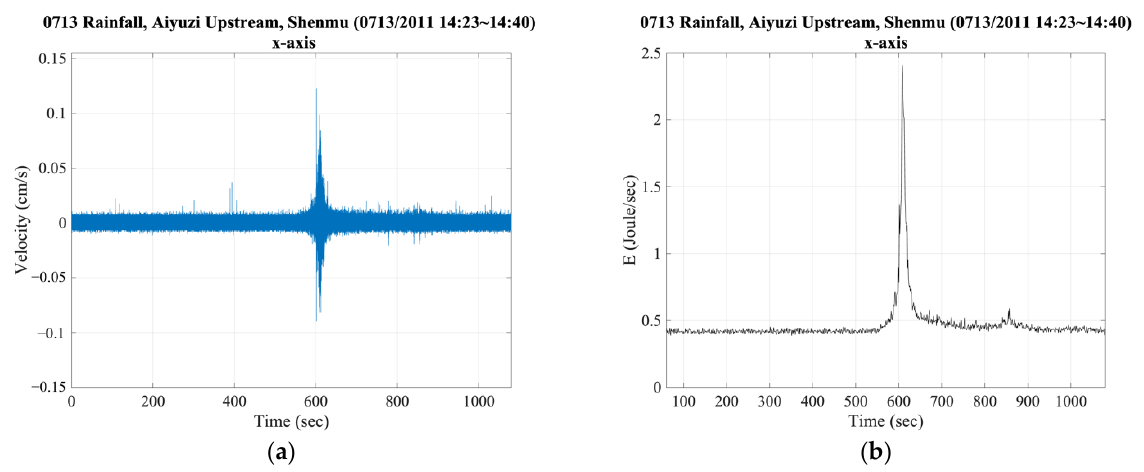
Figure 3. The data of 0713 Rainfall in 2011 ( a ) vibration signals ( b ) accumulated energy per second.